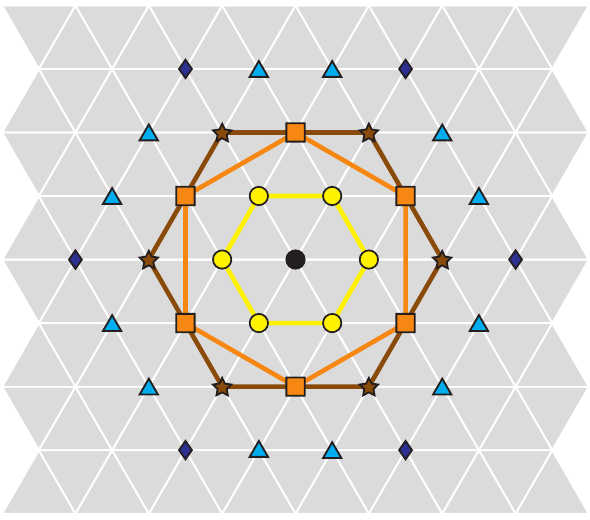
Figure A1. The Wigner lattice of 2D repulsing electrons deposited on the positive jellium with indicated nearest neighbors and next-nearest ones up to 4-th rank. The hexagonal structure of consecutive sublattices of next-nearest neighboring electrons is